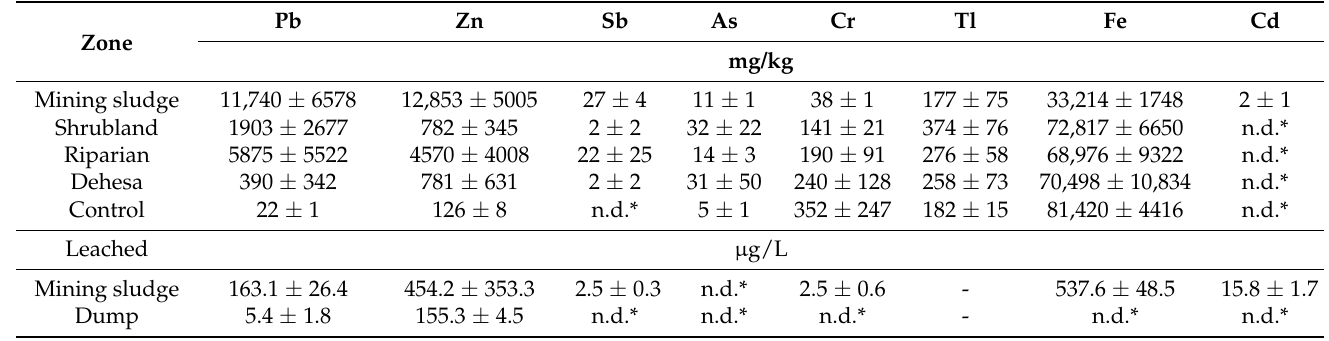
Table 2. Average concentration of metal(loid)s in mining sludge, soils, and leachates. Mining sludge (n = 3), shrubland (n = 4), riparian (n = 12), dehesa (n = 21), control (n =